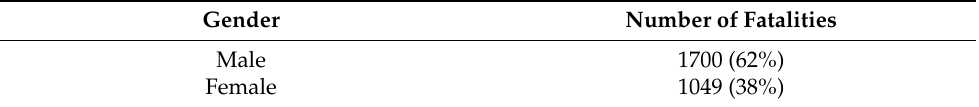
Table 6. Flood fatalities by